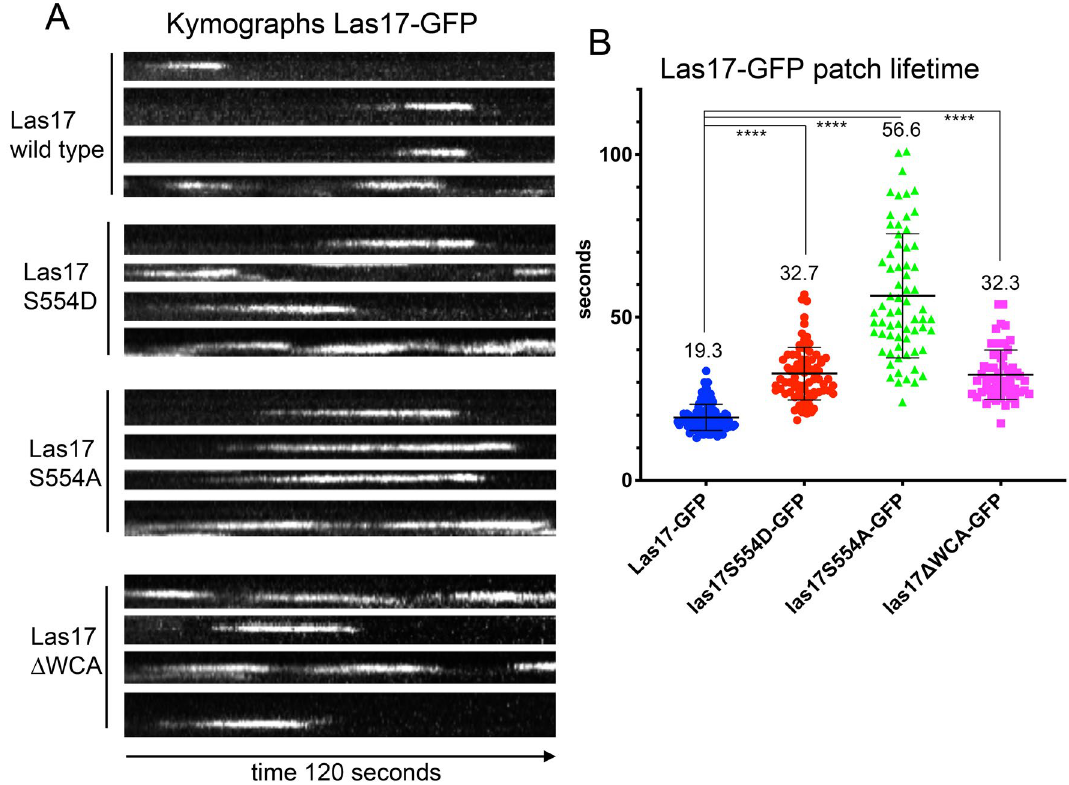
Figure 3. The effect of Las17S554 mutations on Las17-GFP in vivo. Wild type or mutant Las17 was tagged in the genome with a 7 × alanine linker and GFP and visualized as described. ( A ) Representative kymographs showing Las17-GFP. Vertical axis = distance from membrane, horizontal axis = time. ( B ) Lifetimes of patches were measured (combined data from from ≥ 3 experiments ≥ 5 cells on each occasion; n = 112 wt, n = 78 S554D, n = 67 S554A, n = 62 las17∆WCA). One way ANOVA with Dunnetts multiple comparison test indicates that all mutants show a significantly longer lifetime than the wild type protein n ( p < 0.0001 in all cases). The Las17S554D and Las17∆WCA